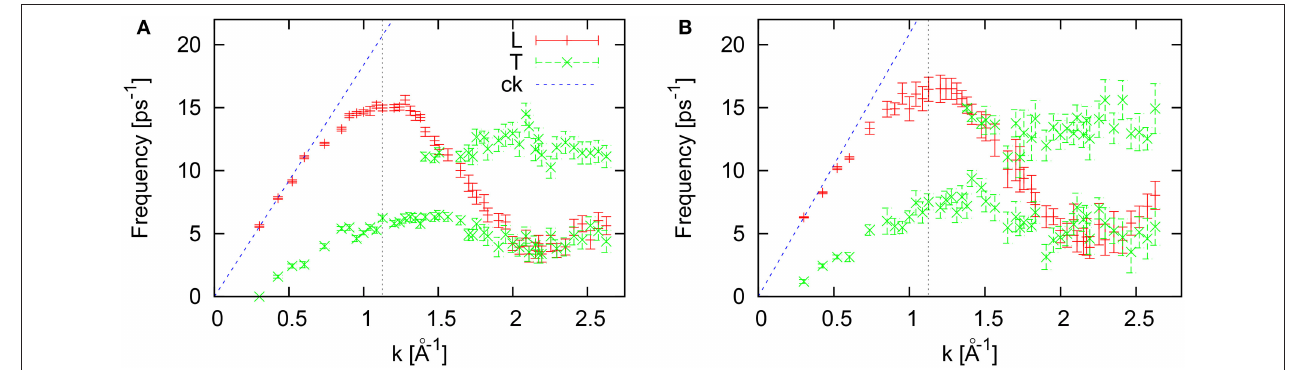
FIGURE 12 | Dispersion of logitudinal (L) and transverse (T) collective excitations for liquid Tl at 577 K estimated from peak positions of the L/T current spectral functions in LDA (A) and GGA (B) . The vertical dashed line at k = 1.125Å − 1 corresponds to the boundary of the first pseudo-Brillouin